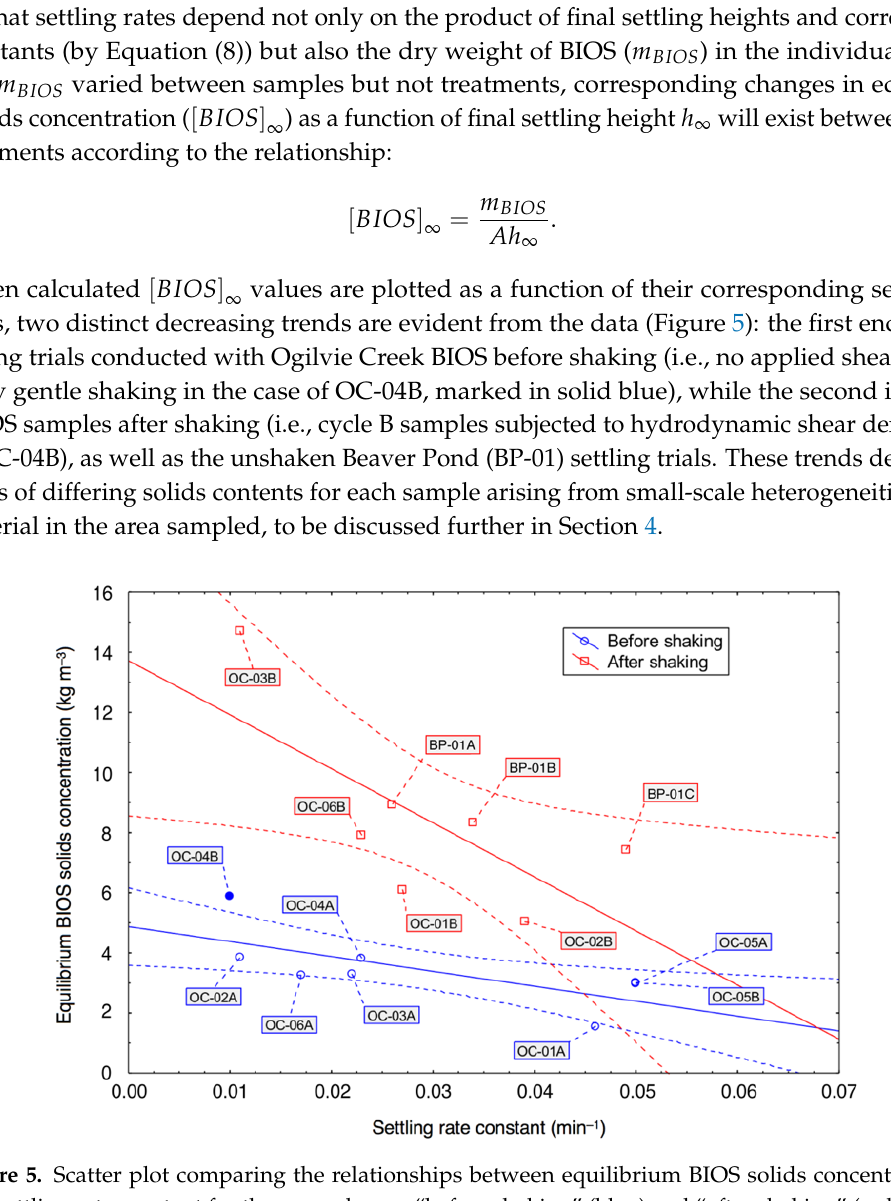
Figure 5. Scatter plot comparing the relationships between equilibrium BIOS solids concentration and settling rate constant for the general cases “before shaking” (blue) and “after shaking” (red) with sample- and cycle-marked data points (e.g., OC-01A, OC-02B) and solid regression lines with dotted 90% confidence intervals.